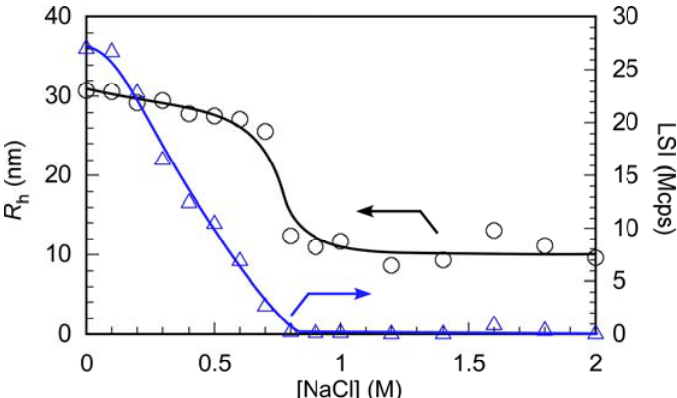
Figure 7. Hydrodynamic radius ( R h , ○ ) and light scattering intensity (LSI, (cid:52) ) of PIC micelles with f + = 0.5 at C p = 1.0 g/L as a function of NaCl concentration ([NaCl]).